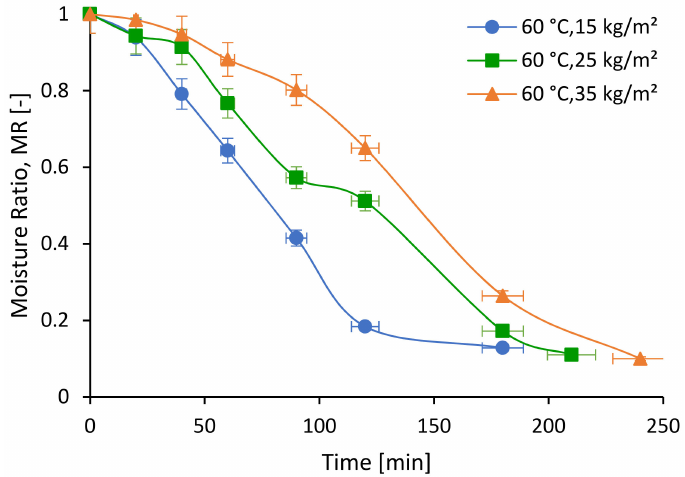
Figure 5. Moisture ratio (MR) vs. time (min) for hops with three di ff erent bulk weights dried at 60 ◦ C and 0.35 m /